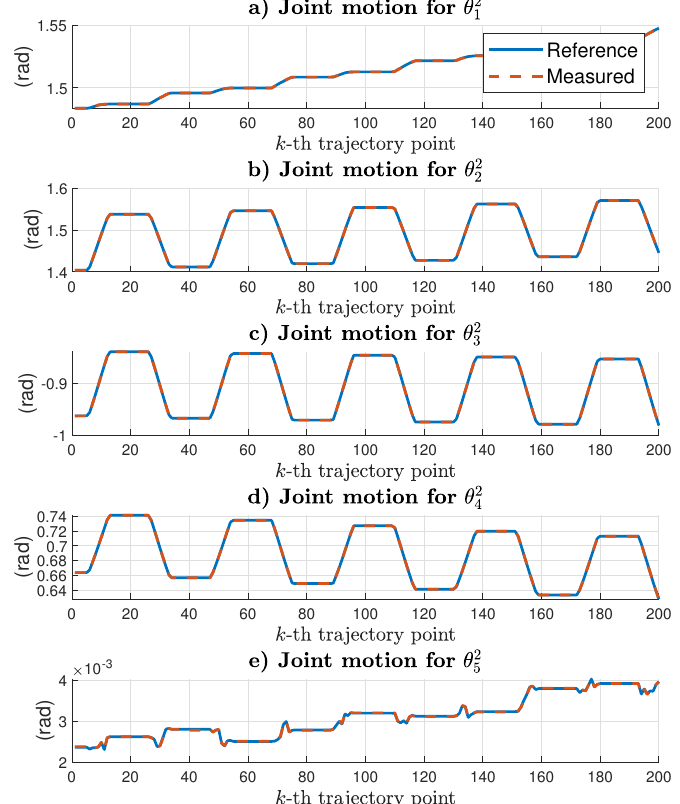
Figure 13. Motion result for manipulator 2. The “Reference” label indicates the optimal joint value provided by the CMA-ES algorithm, and the “Measured” label is the current measurement.